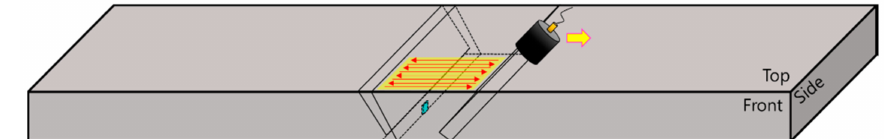
Figure 18. Experimental setup for detecting a defect in the DMW specimen by ultrasonic angular incidence through stainless steel.